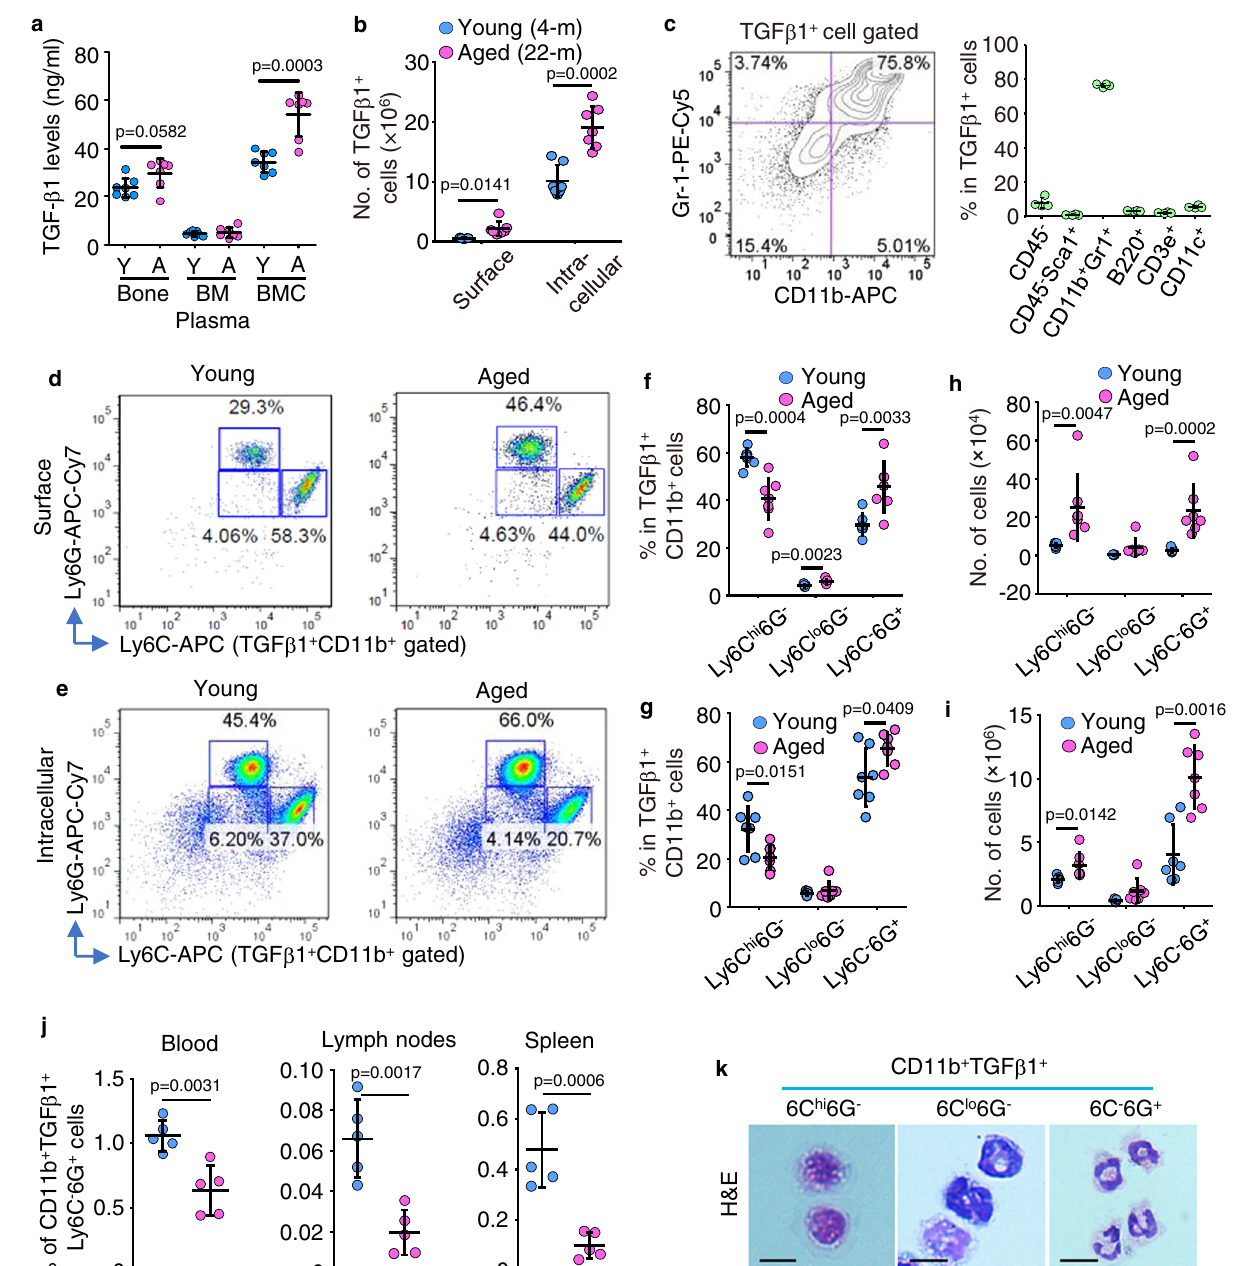
Fig. 1 | Neutrophils are the major cellular source of TGF β 1 in BM from aged mice. a Expression levels of TGF β 1 in protein lysates from bone (with BM fl ushed out), BM cells (BMC), and BM plasma from one leg from young (2 – 4-mon-old) and aged (18 – 22-mon-old) male C57 mice using ELISA. Mean±SD ( n =7 biologically independent male mice/group). b Surface and intracellular expression of TGF β 1 tested by FACS in BM cells from 4- and 22-mon-old C57 mice. Mean±SD ( n =7 biologically independent male mice/group). c Enrichment of TGF β 1 + BM cells in CD11b + Gr1 + myeloid cells and percentages of various types of BM cells expressing TGF β 1 in BM. Mean±SD ( n =4 biologically independent male mice). d , e FACS analysis of Ly6C + and Ly6G + subpopulations in TGF β 1 + CD11b + myeloid cells with